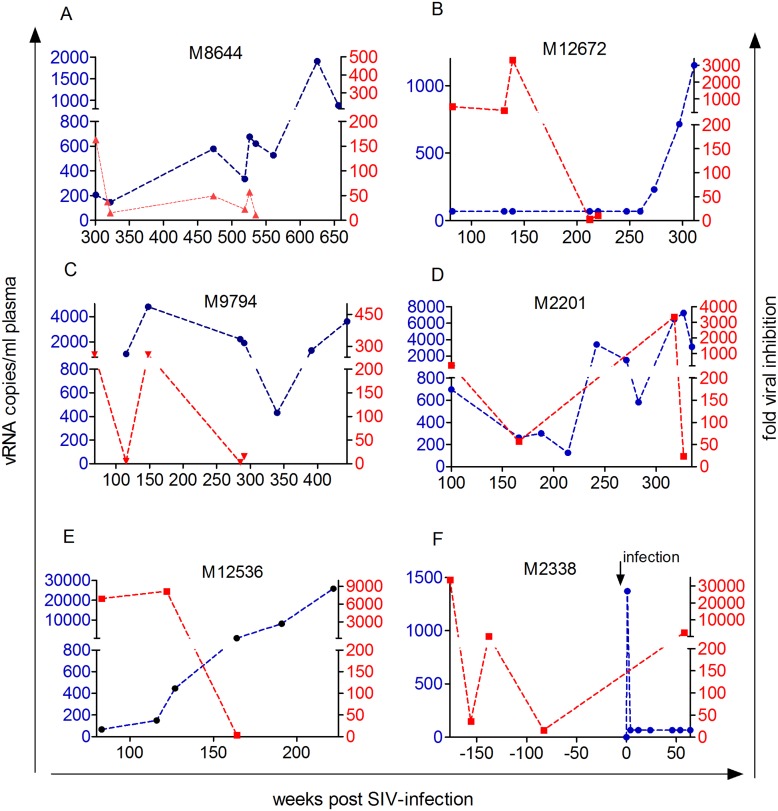
Longitudinal analysis of CD8-mediated in vitro viral inhibition (red dashed line) and plasma viral load.(blue dashed line) in five LTNPs that finally lost CNAR (A-E), and one macaque pre and post infection (F). Time line starts when first viral inhibition test was performed. One time point typically reflects the mean of fold inhibition determined with CD4+ cells from two donors. Respective monkey IDs are shown in each graph.